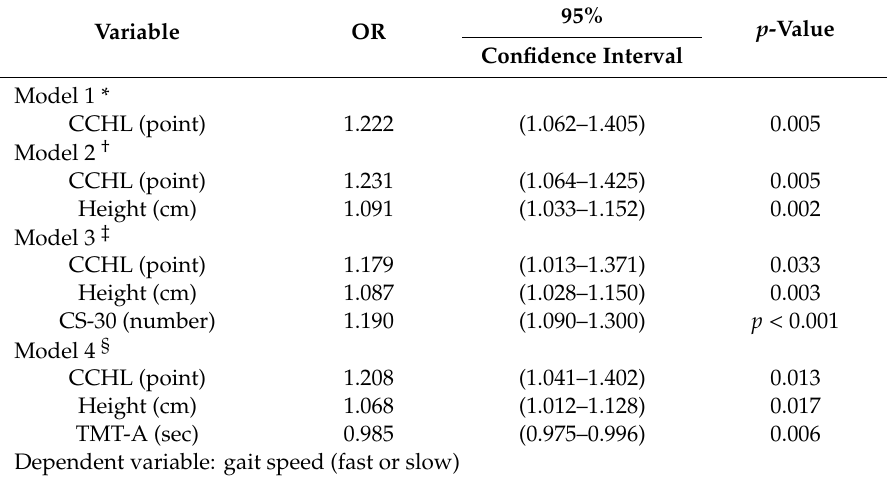
Table 2. Logistic regression analysis with gait speed as the dependent